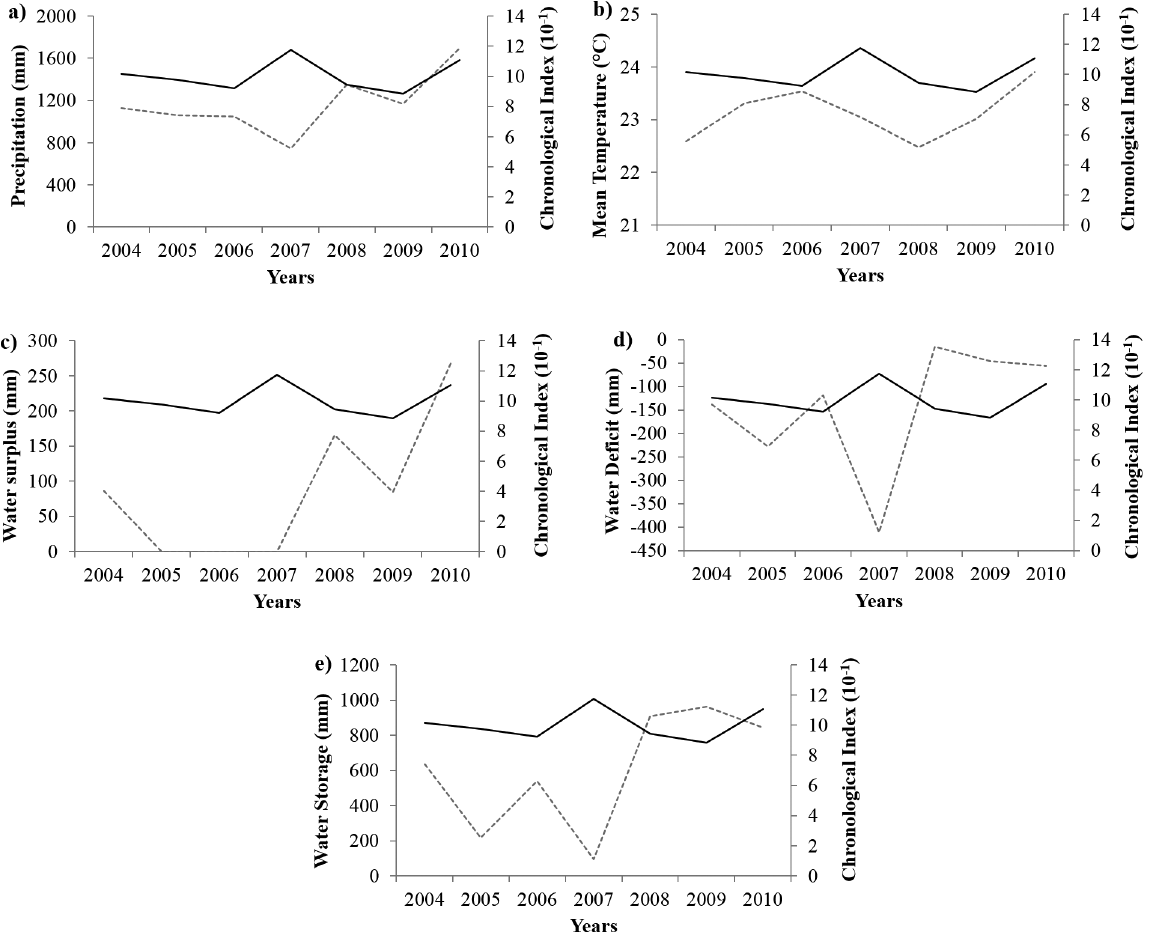
Figure 5 - Line plots showing the indexed master chronology (black lines) against climate parameters (grey dashed lines): ( a ) precipitation; ( b ) mean temperature; ( c ) water surplus; ( d ) water de fi cit; and ( e ) water storage. No signi fi cant correlation (p < 0.05) between the master chronology and the climate parameters was